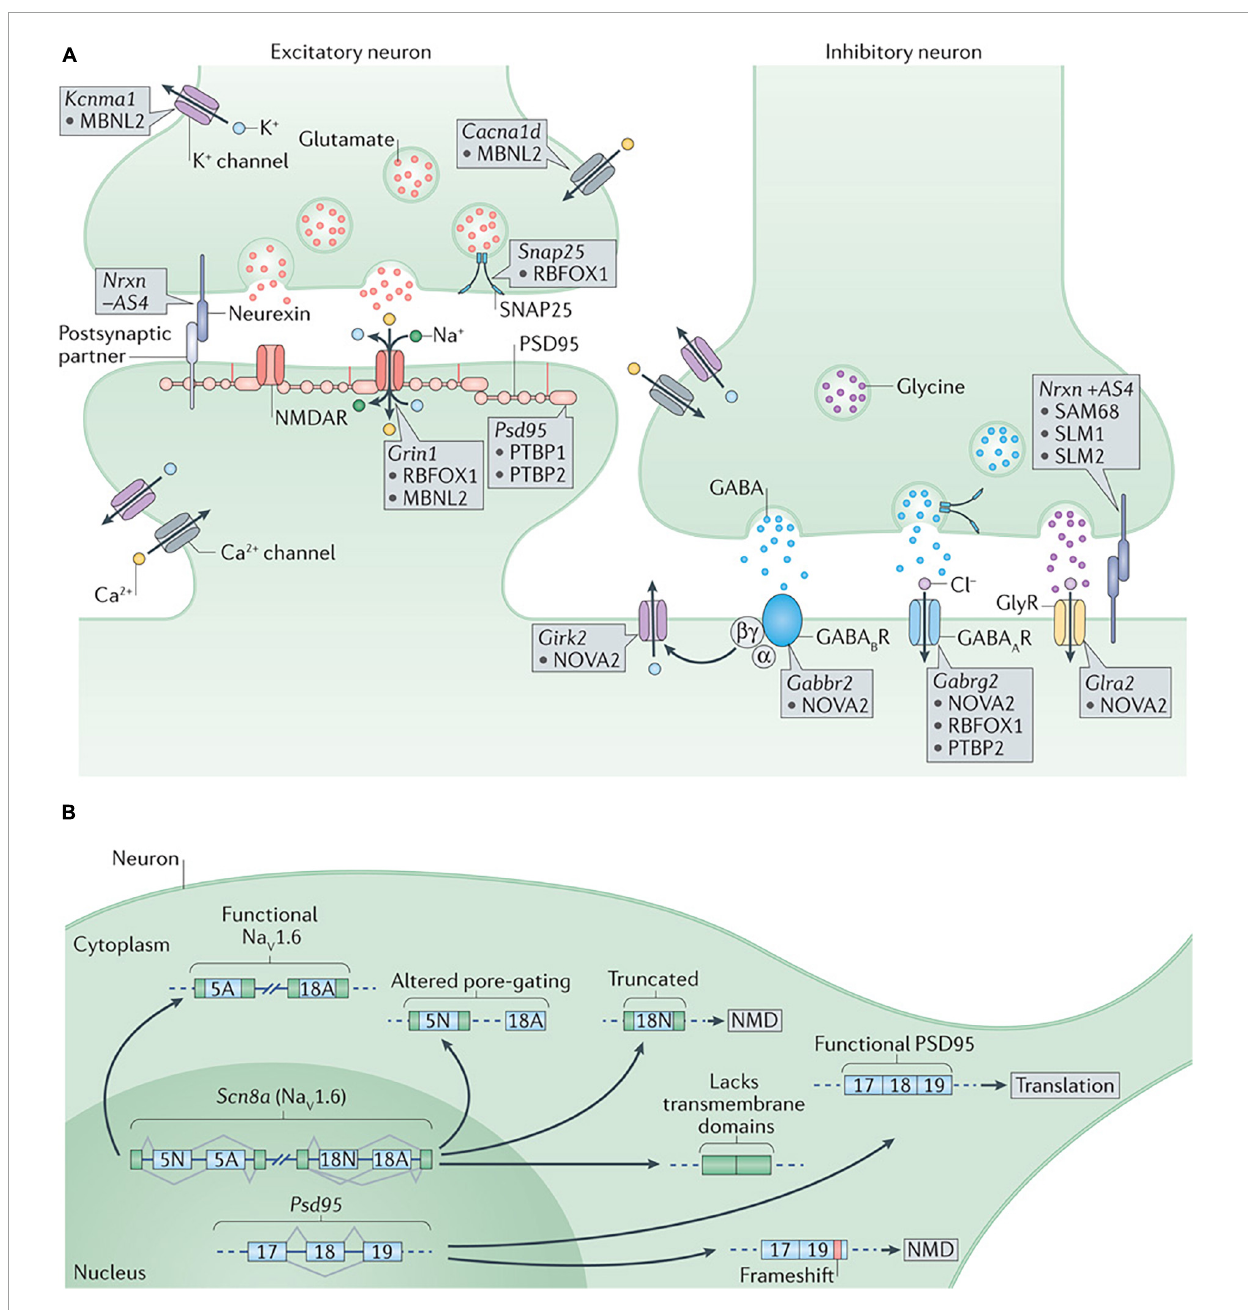
FIGURE3 (A) Alternative splicing regulation of synaptogenesis and synaptic function. At the presynaptic terminal, alternative splicing of synaptosomal-associated protein 25 (Snap25) by RNA-binding protein fox 1 homolog 1 (RBFOX1/A2BP1) and of the calcium-activated potassium channel subunit alpha 1 (Kcnma1) by muscleblind-like 2 (MBNL2) are important to control neurotransmitter release. Differential splicing of the presynaptic neurexins (Nrxns) at AS4 by KHDRBS proteins (SAM68, SLM1, and SLM2) controls targeting to postsynaptic partners. At excitatory synapses, alternative splicing of the transcript encoding the NMDA receptor subunit GluN1, Grin1, is regulated by RBFOX1 (A2BP1) and MBNL2, whereas the polypyrimidine tract binding proteins (PTBPs) control productive splicing of the scaffold protein, postsynaptic density protein 95 (Psd95). Splicing of the transcripts encoding L-type voltage-gated calcium channels, such as the pore-forming subunit Cav1.3 (encoded by Cacna1d), by MBNL2 may allow the voltage sensitivity, conductance, or other properties to be tuned as synapses differentiate. At inhibitory synapses, neuro-oncological ventral antigen 2 (NOVA2) mediates alternative splicing of the transcripts encoding many postsynaptic components such as the metabotropic GABAB receptor (Gabbr2), the inwardly rectifying potassium channel Kir3.2 (Girk2) and the glycine receptor alpha 2 (Glra2). Splicing of the GABAA receptor subunit transcript (Gabrg2) is controlled by multiple splicing regulators including NOVA2, RBFOX1 (A2BP1) and PTBP2. (B) Alternative splicing regulation of synaptogenesis and synaptic function. Alternative splicing controls the expression and function of many synaptic components. Expression of PSD95 is repressed by PTBP-controlled exclusion of exon 18 until late in neuronal maturation when it is required for synaptogenesis. The gene encoding the voltage-gated sodium channel Nav1.6, Scn8a, has multiple alternative exons (such as 5N,